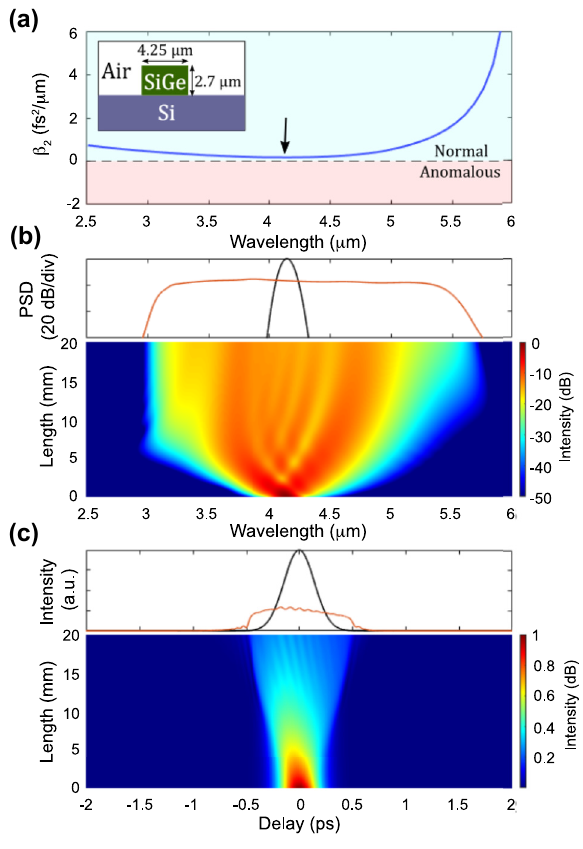
Figure 5: SCG in normal dispersion regime. (a) Simulated group velocity ) for the fundamental TM mode of a SiGe/Si waveguide. dispersion ( 𝛽 2 The arrow indicates the position of the pump at around 4.15 μ m. Inset: schematic of the SiGe waveguide geometry. (b) Simulated normalized spectral evolution (bottom) along the propagation direction, input (black) and output (red) spectra (top) when 200 fs pulses with 3.1 kW peak power are injected in the TM mode. (c) Corresponding temporal evolution along the propagation direction (bottom), input (black) and output (red) temporal envelope